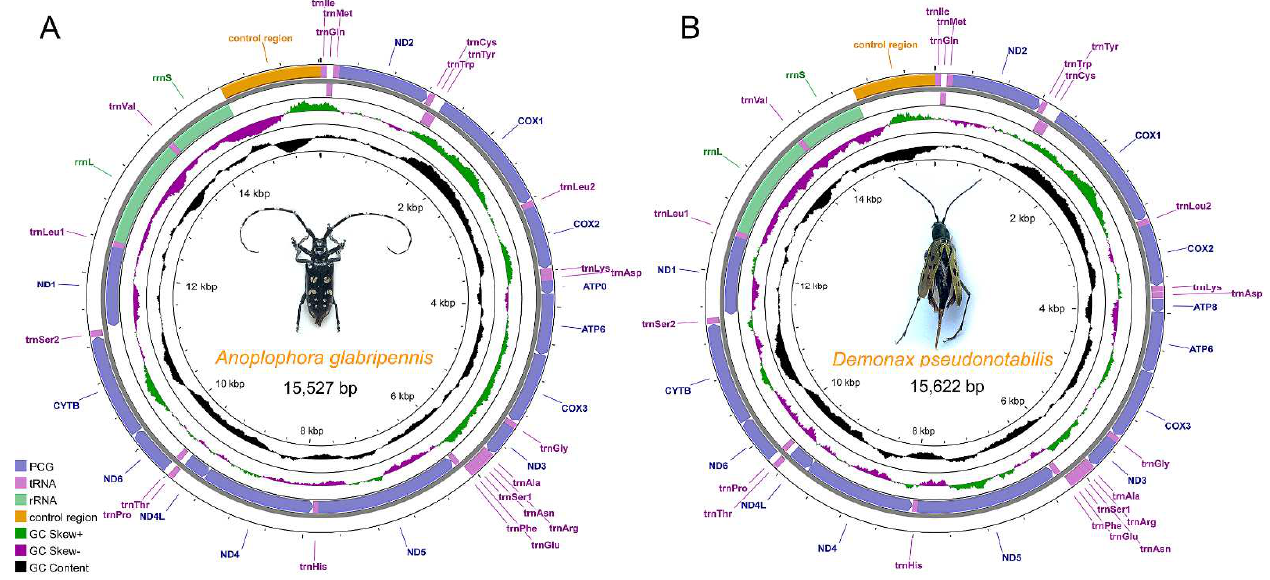
Figure 1. Mitochondrial genome maps of A. glabripennis ( A ) and D. pseudonotabilis ( B ). Genes outside the map are transcribed clockwise, whereas those inside the map are transcribed counterclockwise. The inside circles show the GC content and the GC skew. GC content and GC skew are plotted as the deviation from the average value of the entire sequence. Table 2. Mitochondrial genome organization of A. glabripennis.